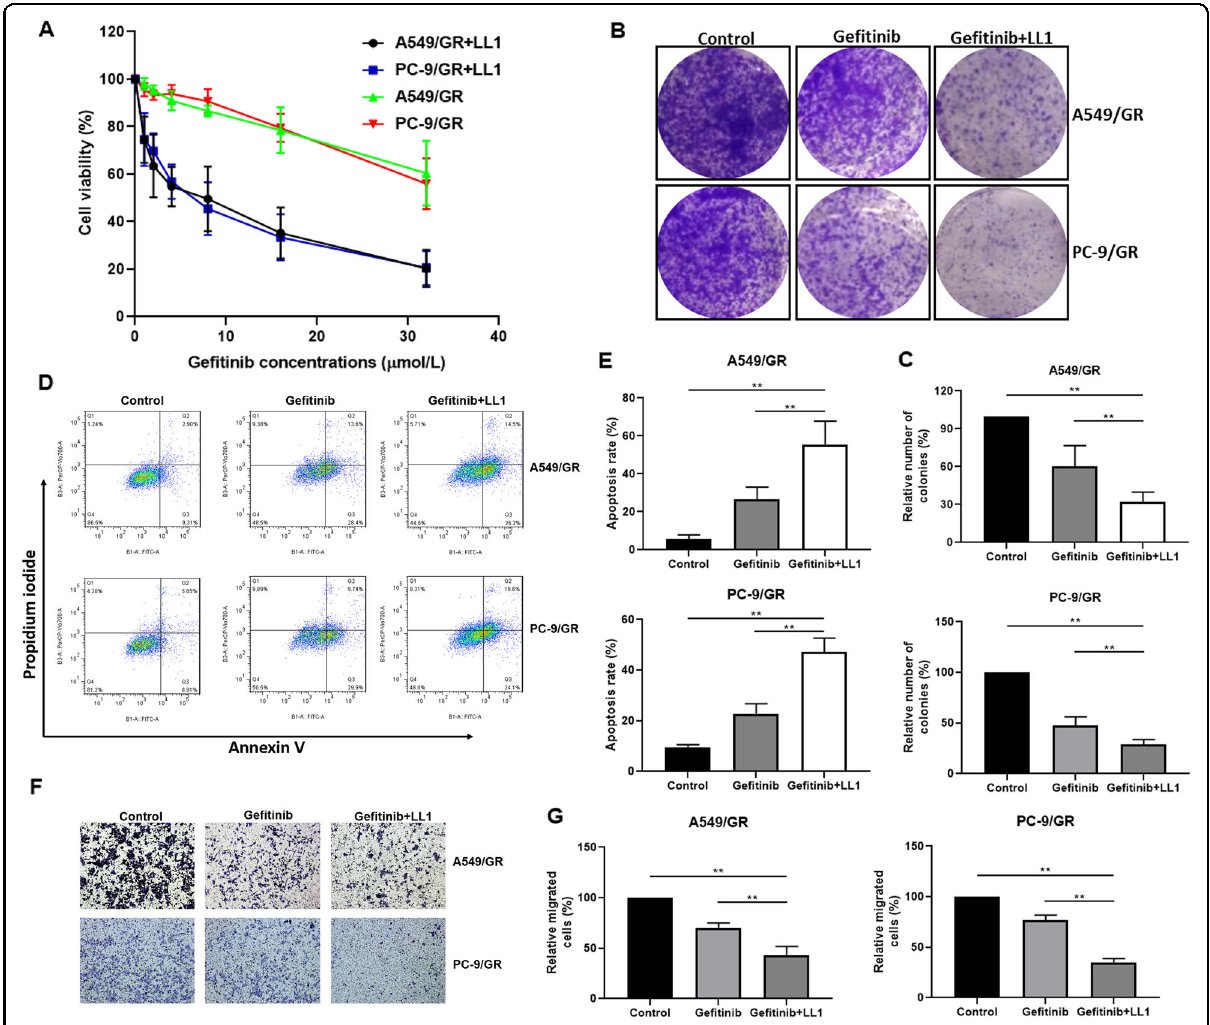
Fig. 5 The combination of ge fi tinib and LL1 reverses resistance in lung cancer cells. A LL1 sensitizes the A549/GR and PC-9/GR cells to ge fi tinb in vitro. Cell viability was determined using the MTT assay. B A549/GR and PC-9/GR cells were seeded in six-well plates, incubated overnight, and treated with ge fi tinib (16 μ mol/L) or in combination with LL1 (2 μ mol/L) for 7 days. Effect of LL1 and ge fi tinib on cell proliferation determined by colony formation assay. C Quanti fi cation of colony formation. D Flow cytometry analysis of apoptotic death of A549/GR and PC-9/GR cells. Cells were treated with either drug alone (16 μ mol/L ge fi tinib) or in combination with LL1 (2 μ mol/L) for 24 h, and stained with Annexin V/PI. E Quanti fi cation of PI and Annexin V staining. F Effect of ge fi tinib (16 μ mol/L) or ge fi tinib (16 μ mol/L) plus LL1 (2 μ mol/L) on A549/GR and PC-9/GR cell invasion was determined by transwell assay. G Quanti fi cation of transwell. The Data were mean ± SD, n = 3. **p value < 0.01, signi fi cantly